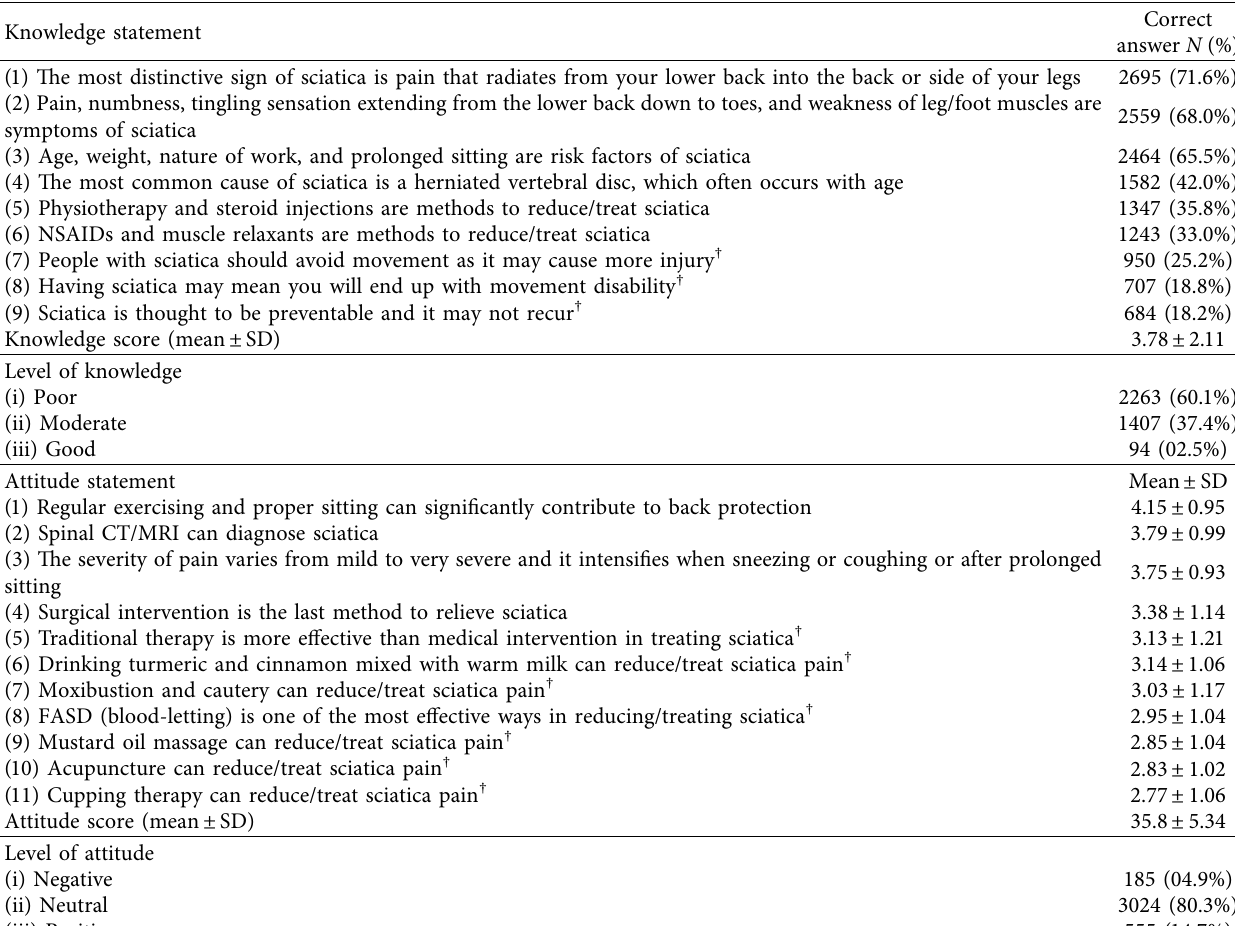
Table 1: Knowledge and attitude toward sciatica pain ( n � 3.764)